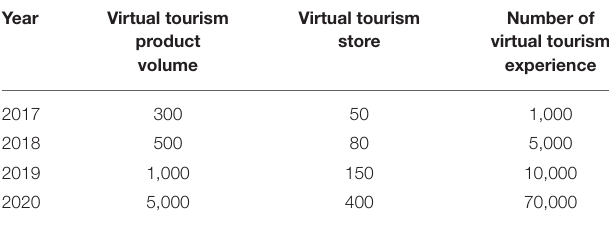
TABLE 5 | The economic effect of virtual